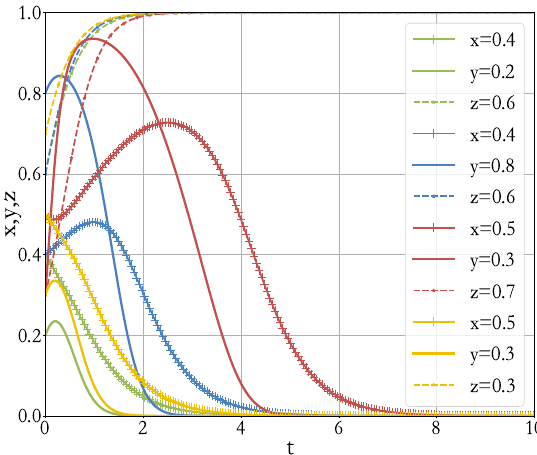
Figure 6. The effect of different initial